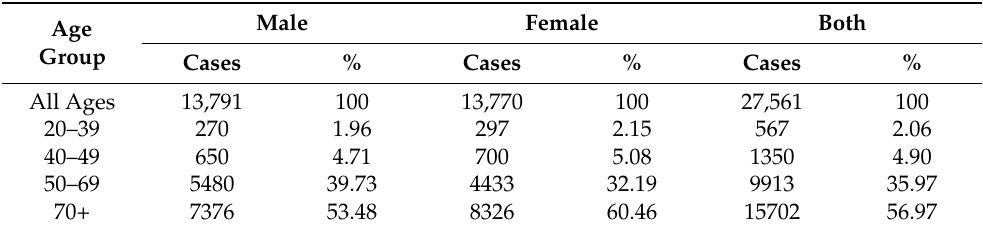
Table 1. Number and percentage of incident colorectal cancers by age group and sex, Uruguay, 2002–2017.